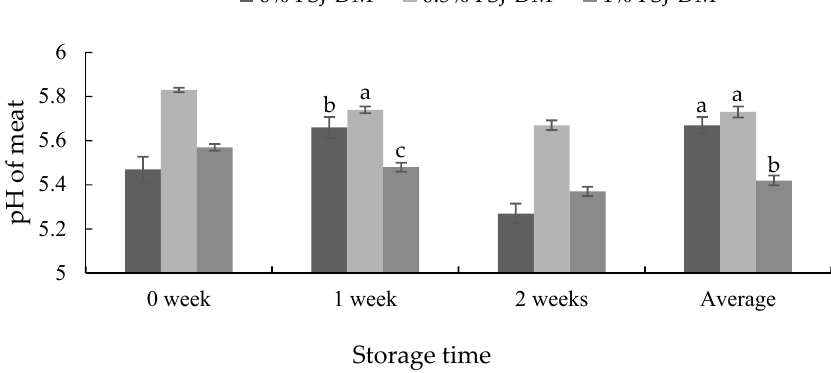
Figure 2. Effects of fermented S. japonica and D. morbifera (FSJ-DM) on the meat pH from Korean native black goats. Data are presented as mean ± SE. a, b, c Values with different superscripts in the same storage period differ significantly ( p < 0.05).